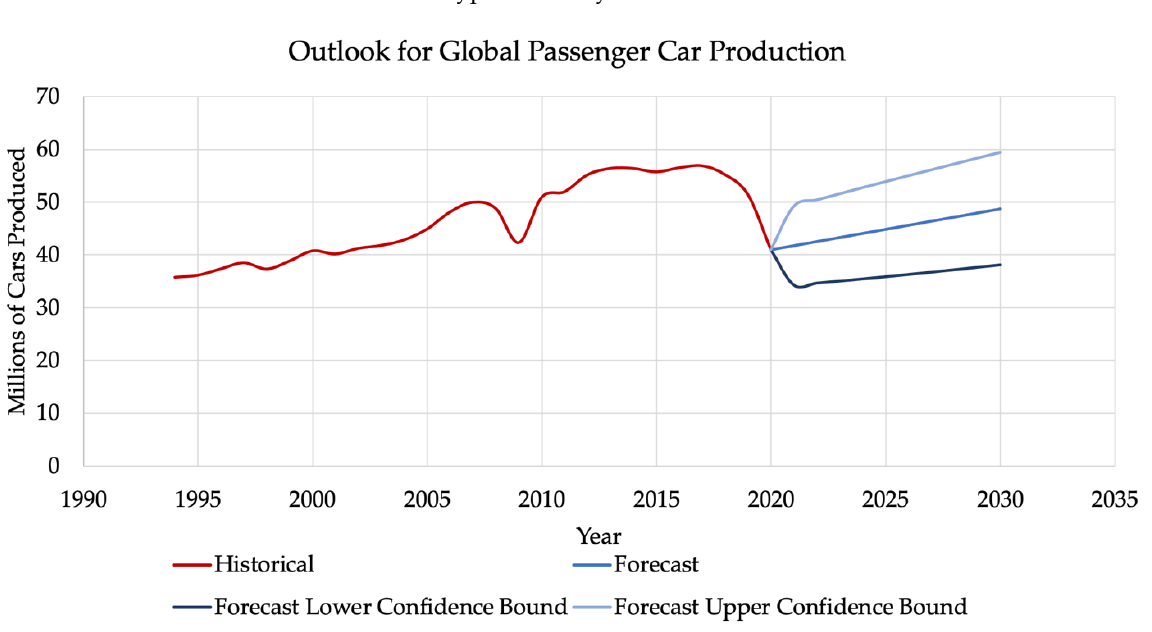
Figure 3. Outlook for global passenger car production with three potential projections.